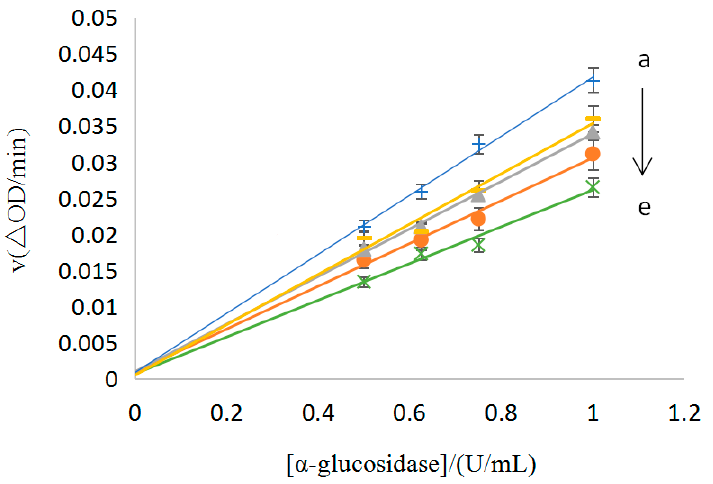
Figure 6. The inhibition of the reversibility of the No.9 sample on the α -glucosidase [C(No.9) = 0.18, 0.19, 0.20, 0.21, and 0.22 mg/mL for the curves a → e, respectively]. 0.19, 0.20, 0.21, and 0.22 mg/mL for the curves a → e,